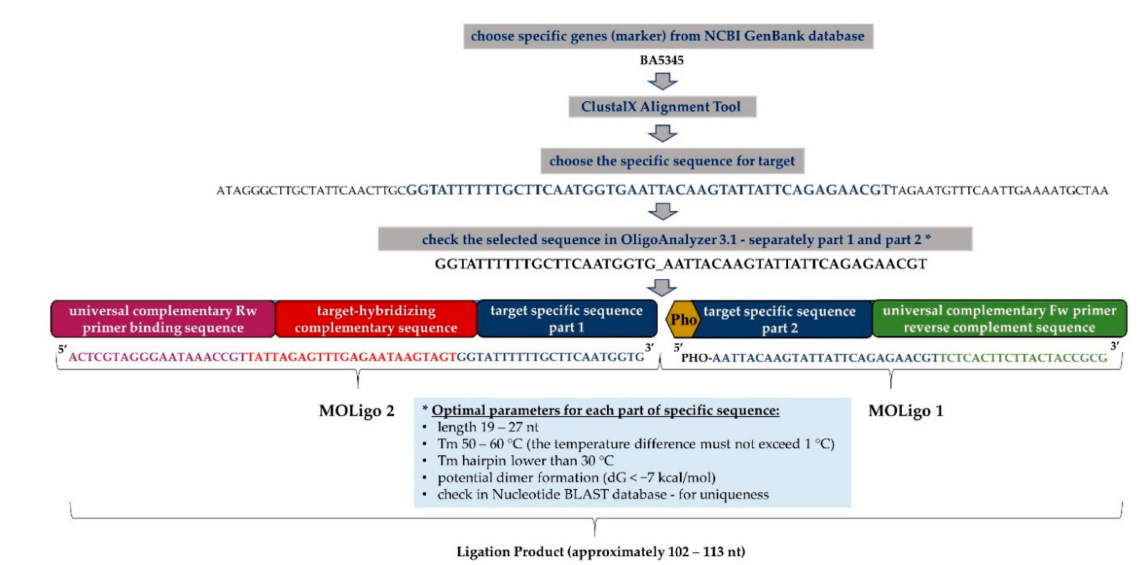
Figure 1. The structure of MOLigo probes demonstrated on a specific marker BA5345 for Bacillus anthracis : ClustalX Align- ment Tool—part of a software program BioEdit, designed to perform mulTable 3. 1—analytical tool for oligonucleotides identifying their properties; MOLigo1 consists of a specific sequence for selected target (part 2) and a universal comple- mentary forward primer (Fw)-binding sequence, MOLigo1-specific sequence is phosphorylated at its 5 (cid:48) end; MOLigo2 includes a specific sequence for selected target (part 1), target-hybridizing complementary sequence, which is specific for each microsphere and universal complementary reverse primer (Rw)-binding sequence. The final size of the ligation product ranges from 102 to 113 nucleotides (nt). * Optimal parameters for target specific sequences defined according to Deshpande et al.